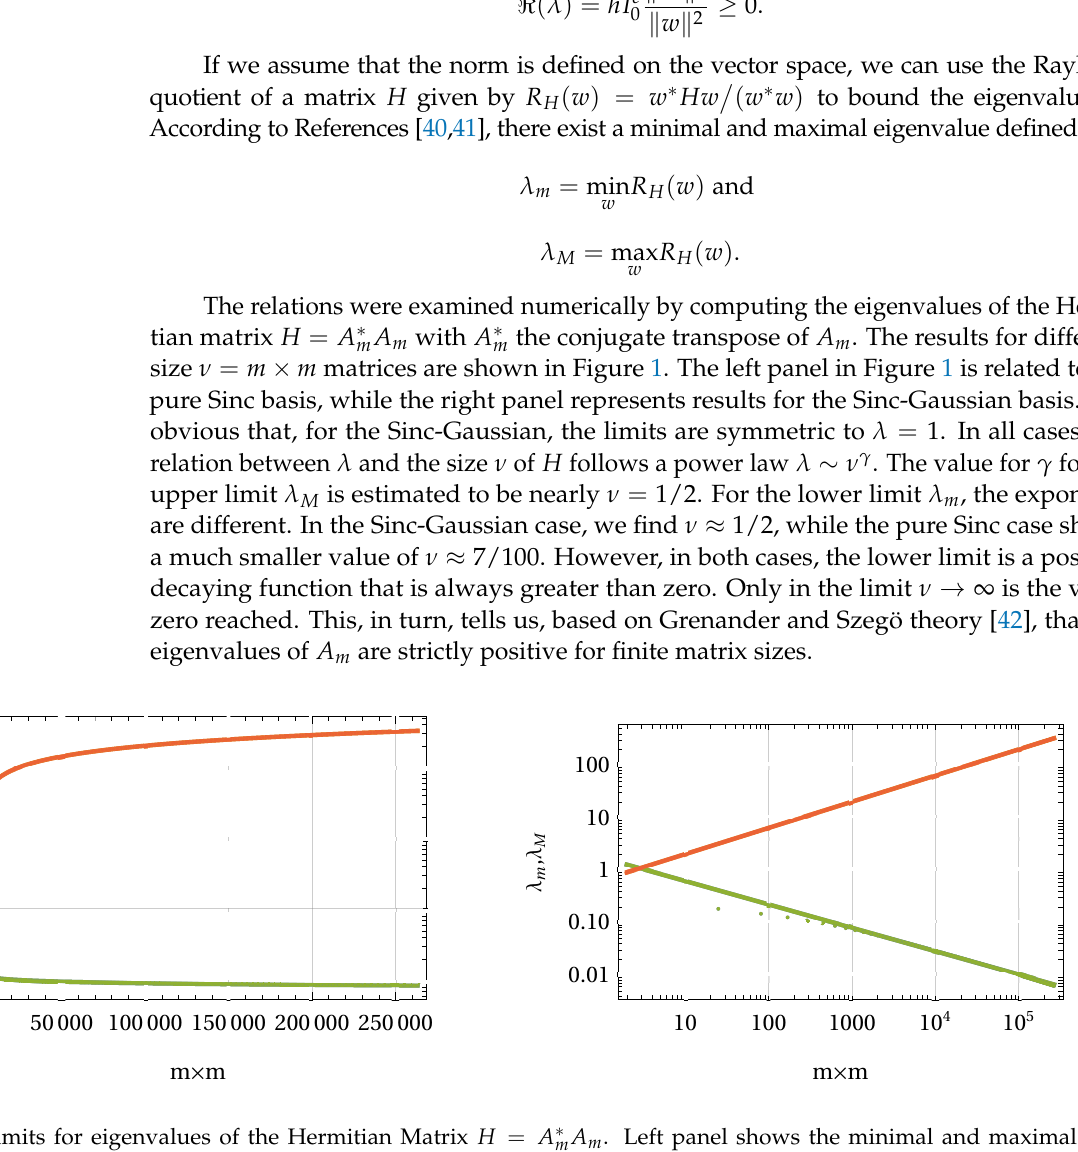
Figure 1. Limits for eigenvalues of the Hermitian Matrix H = A ∗ m A m . Left panel shows the minimal and maximal eigenvalues for a Sinc basis and the right panel for a Sinc-Gaussian basis (log-log plot). The limits follow a relation λ n , M ∼ ν ± γ with ν = m × m the size of H , and γ ≈ 1/2 for the upper limits and γ ≈ 7/100 for the lower limit of a Sinc approximation. The lower limit for Sinc-Gaussian follows the upper limit with the opposite